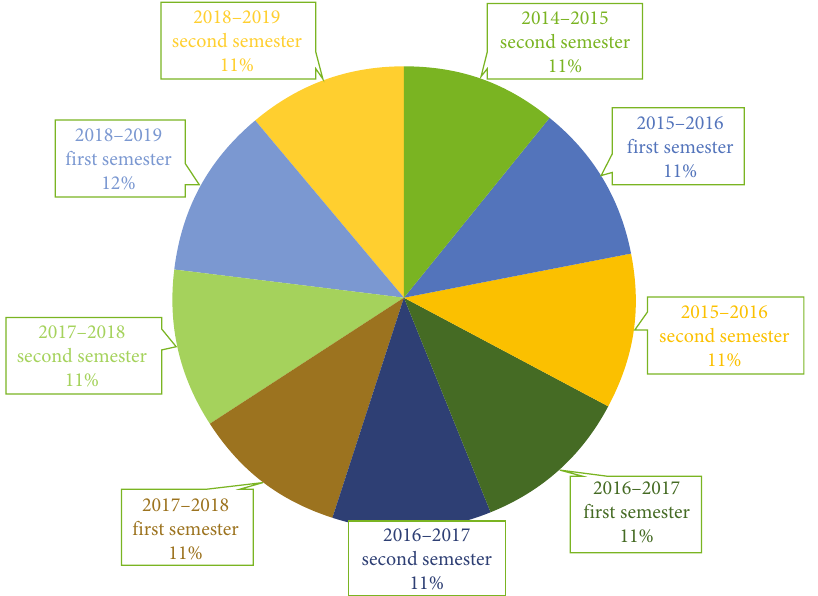
Figure 9: Changes in the proportion of three types of teachers in Y school in the past fi ve